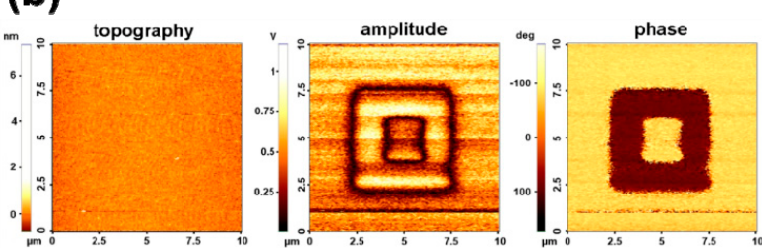
Figure 2. ( a ) Grazing incidence X-ray diffraction (GIXRD) spectra and ( b ) piezo-response force microscopy (PFM) topography (left), amplitude (centre), and phase (right) of the 6-nm-thick HfZrO